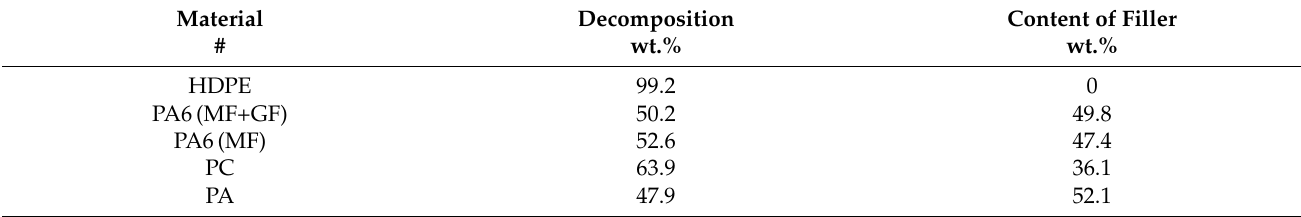
Table 6. Filler content of commercial thermoplastic materials determined by